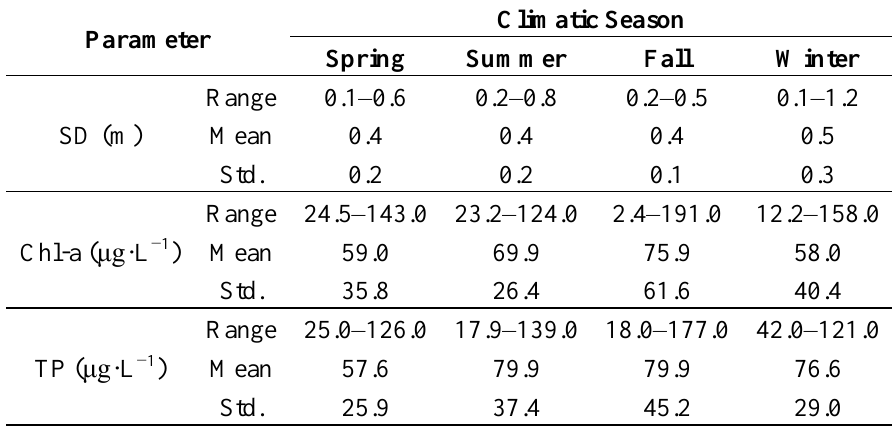
Figure 1. Study site and water sampling points. Table 1. Range, mean, and standard deviation (Std.) of measured parameters at different climatic seasons of Tain-Pu reservoir during the measurement, in situ , from May 2002 to May